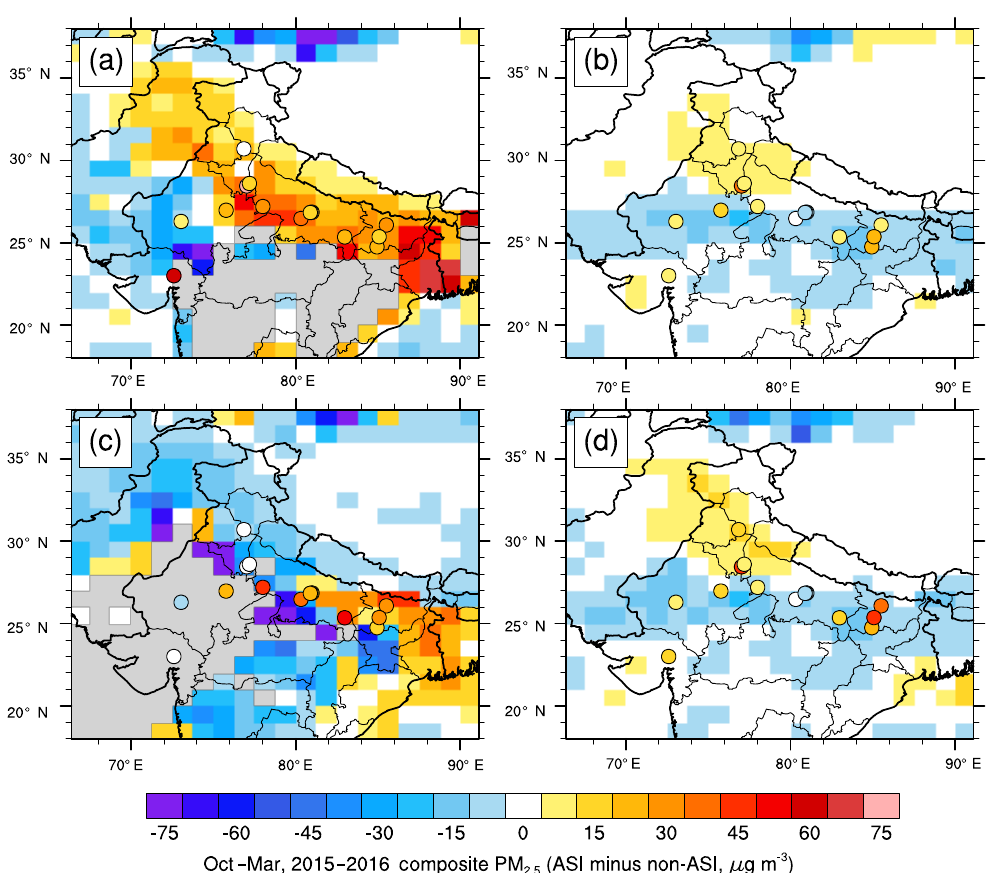
Figure 7. Composite of anomalies of PM 2 . 5 relative to monthly mean on days when ASI components (a) 10m wind speed, (b) 500mb wind speed, (c) precipitation, and (d) total ASI are met minus days when they are not during the period 1 October 2015–31 March